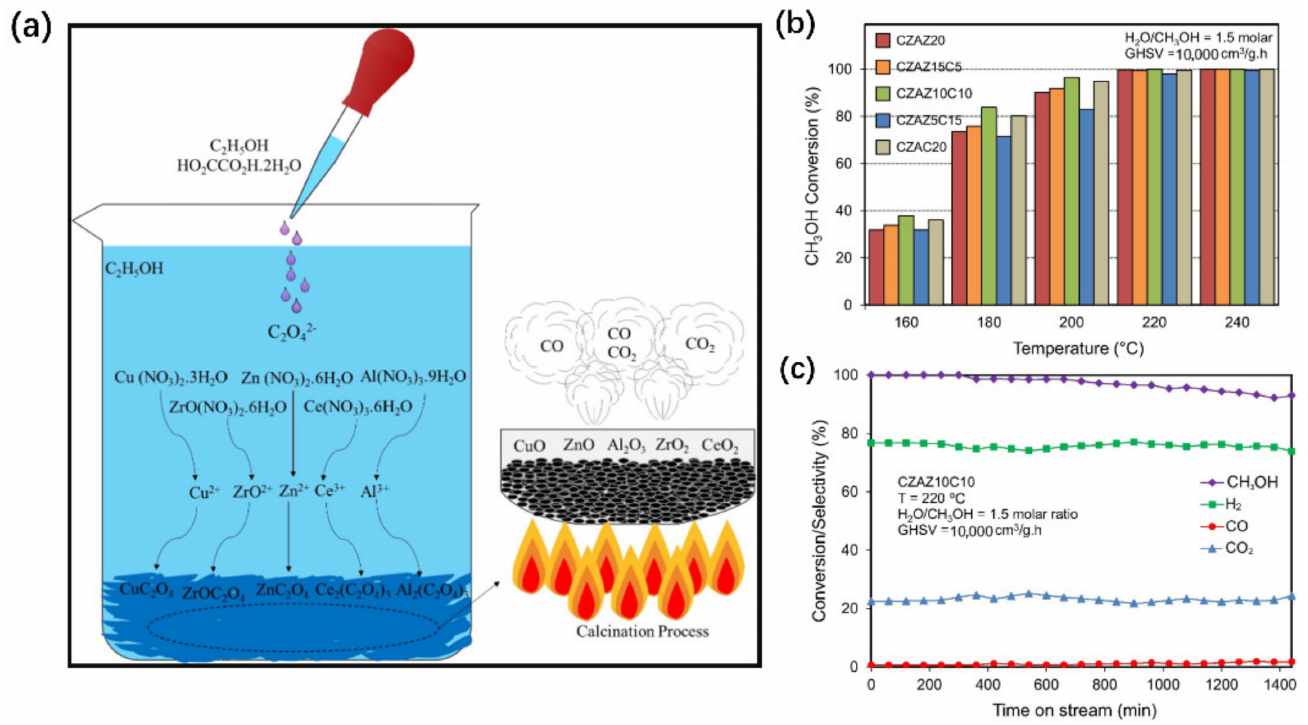
Figure 1. The synthesis of ZrO 2 -CeO 2- promoted CuO-ZnO-Al 2 O 3 nanocatalyst for methanol-to- hydrogen production: ( a ) Illustration of oxalate gel coprecipitation synthesis method; ( b ) influence of ZrO 2 -CeO 2 loading on catalytic performance; and ( c ) runtime performance testing of methanol-to- hydrogen production. Reproduced with permission [49]. Copyright Elsevier, 2017.